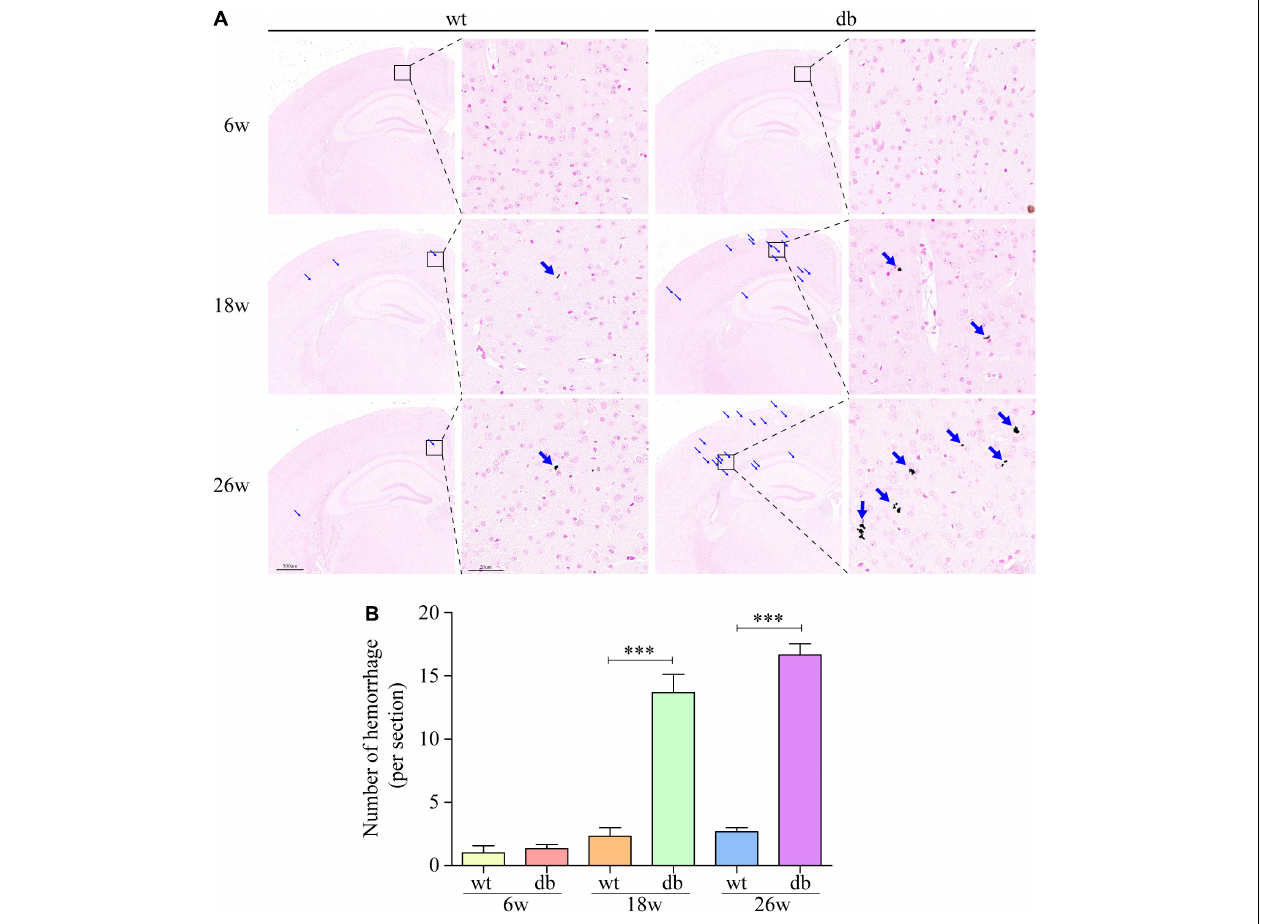
FIGURE 3 | Prussian blue staining was used to detect the microhemorrhage in mice. (A) Representative images of hemorrhages in the cortex. Scale bar = 500 or 20 µ m. The red arrow points to the hemorrhages. (B) Quantitative analysis of hemorrhages. ( n = 3 per group); ∗∗∗ P <